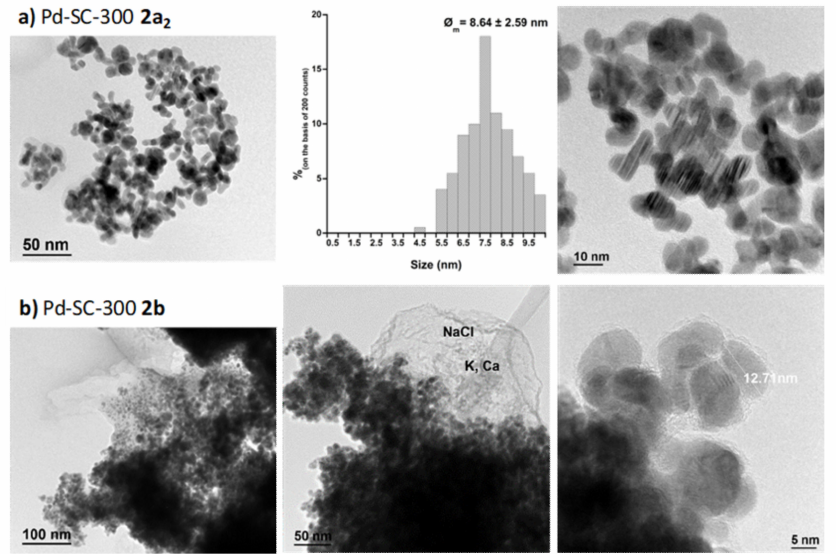
Figure 5. TEM pictures of the different nanoparticle systems of Family 2 prepared by the supercritical fluidic approach in acetone. ( a ) Obtained from Pd(acac) 2 at 300 ◦ C. ( b ) Obtained from Pd(hfacac) 2 at 300 ◦